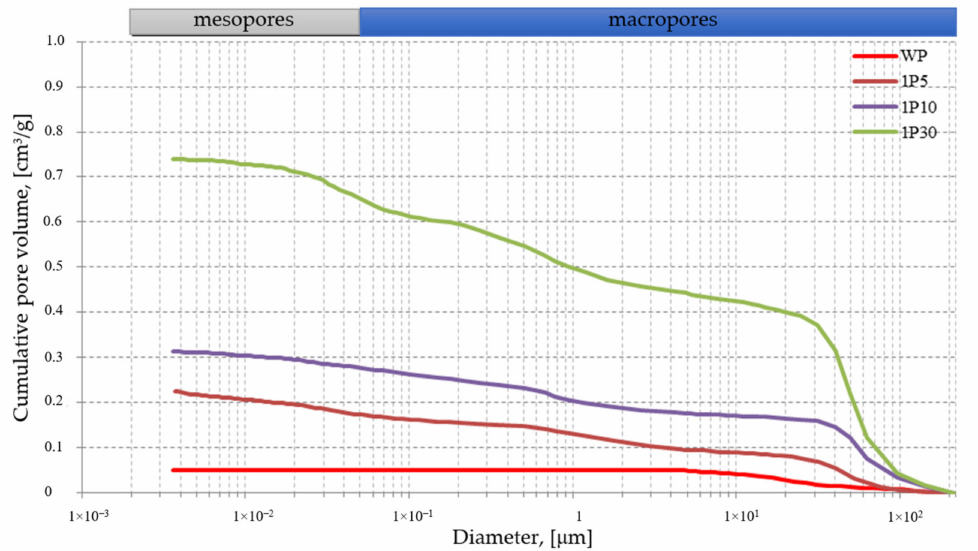
Figure 4. Cumulative pore volume distribution curve for a modified GFG product with a size of 0.25—0.5